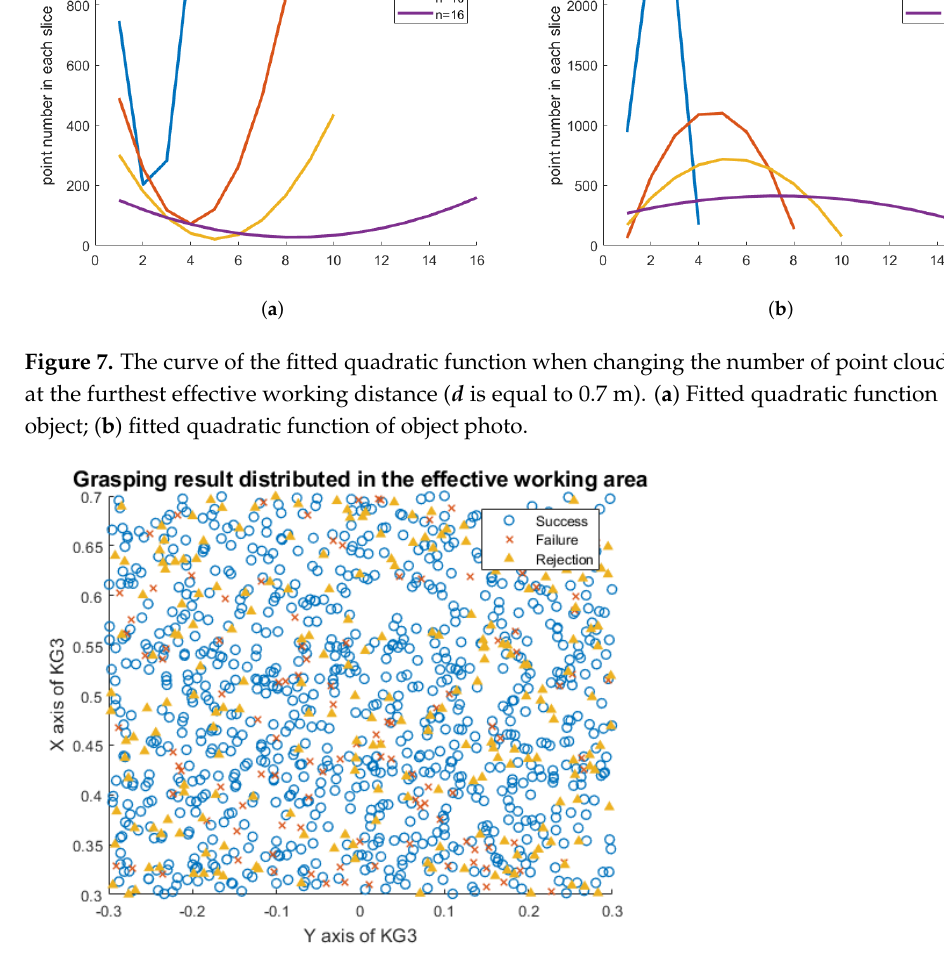
Figure 8. The distribution of grasping results in the KG3 effective working area. Each spot represents the real object or its photos placed in the working area. The coordinate origin denotes the installation position of the KG3. The blue circles denote the success cases of grasping a real object, while the red crosses denote the failure cases, which include the failure of object grasping and photo rejection. In addition, the yellow triangles represent the position where the KG3 rejects the object photos